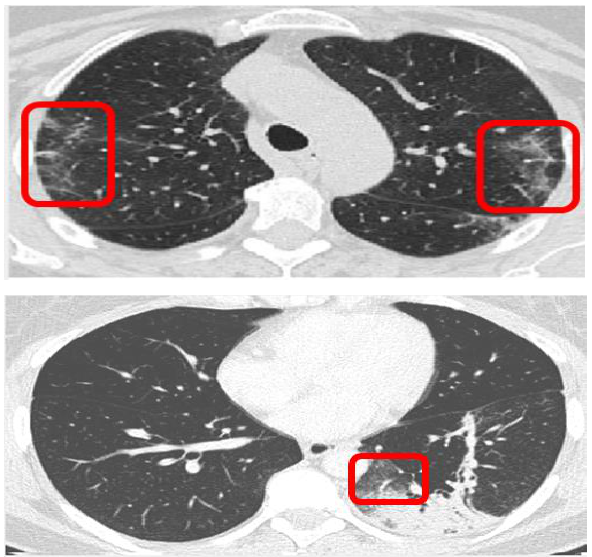
Figure 1. Examples of COVID-19 signatures in CT scans (red rectangles indicate GGO). To generate the most effective training results, the input data was pre-processed with various methods [20]. The approach involved converting grayscale input images into binary images using fuzzy logic to isolate ground-glass opacity sections. Grayscale conversion to binary images presented a variation of results. To extract meaningful features from the training set, fuzzy logic edge detection was used on a binary image that